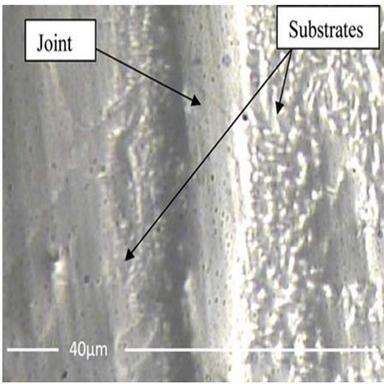
Microstructure of stainless steel joint .